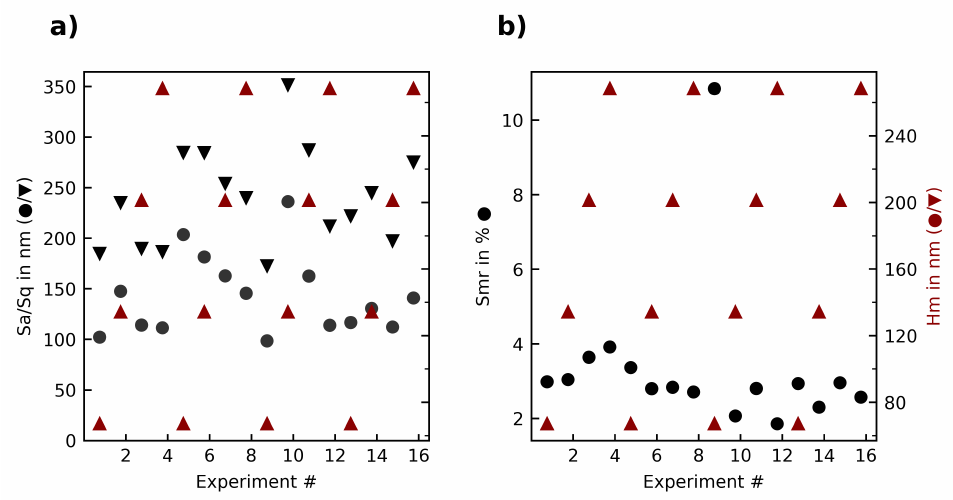
Figure 12. Overview of the ( a ) roughness parameters Sa, Sq; ( b ) surface bearing parameter Smr in relation to the median chip thickness Hm in the third experiment